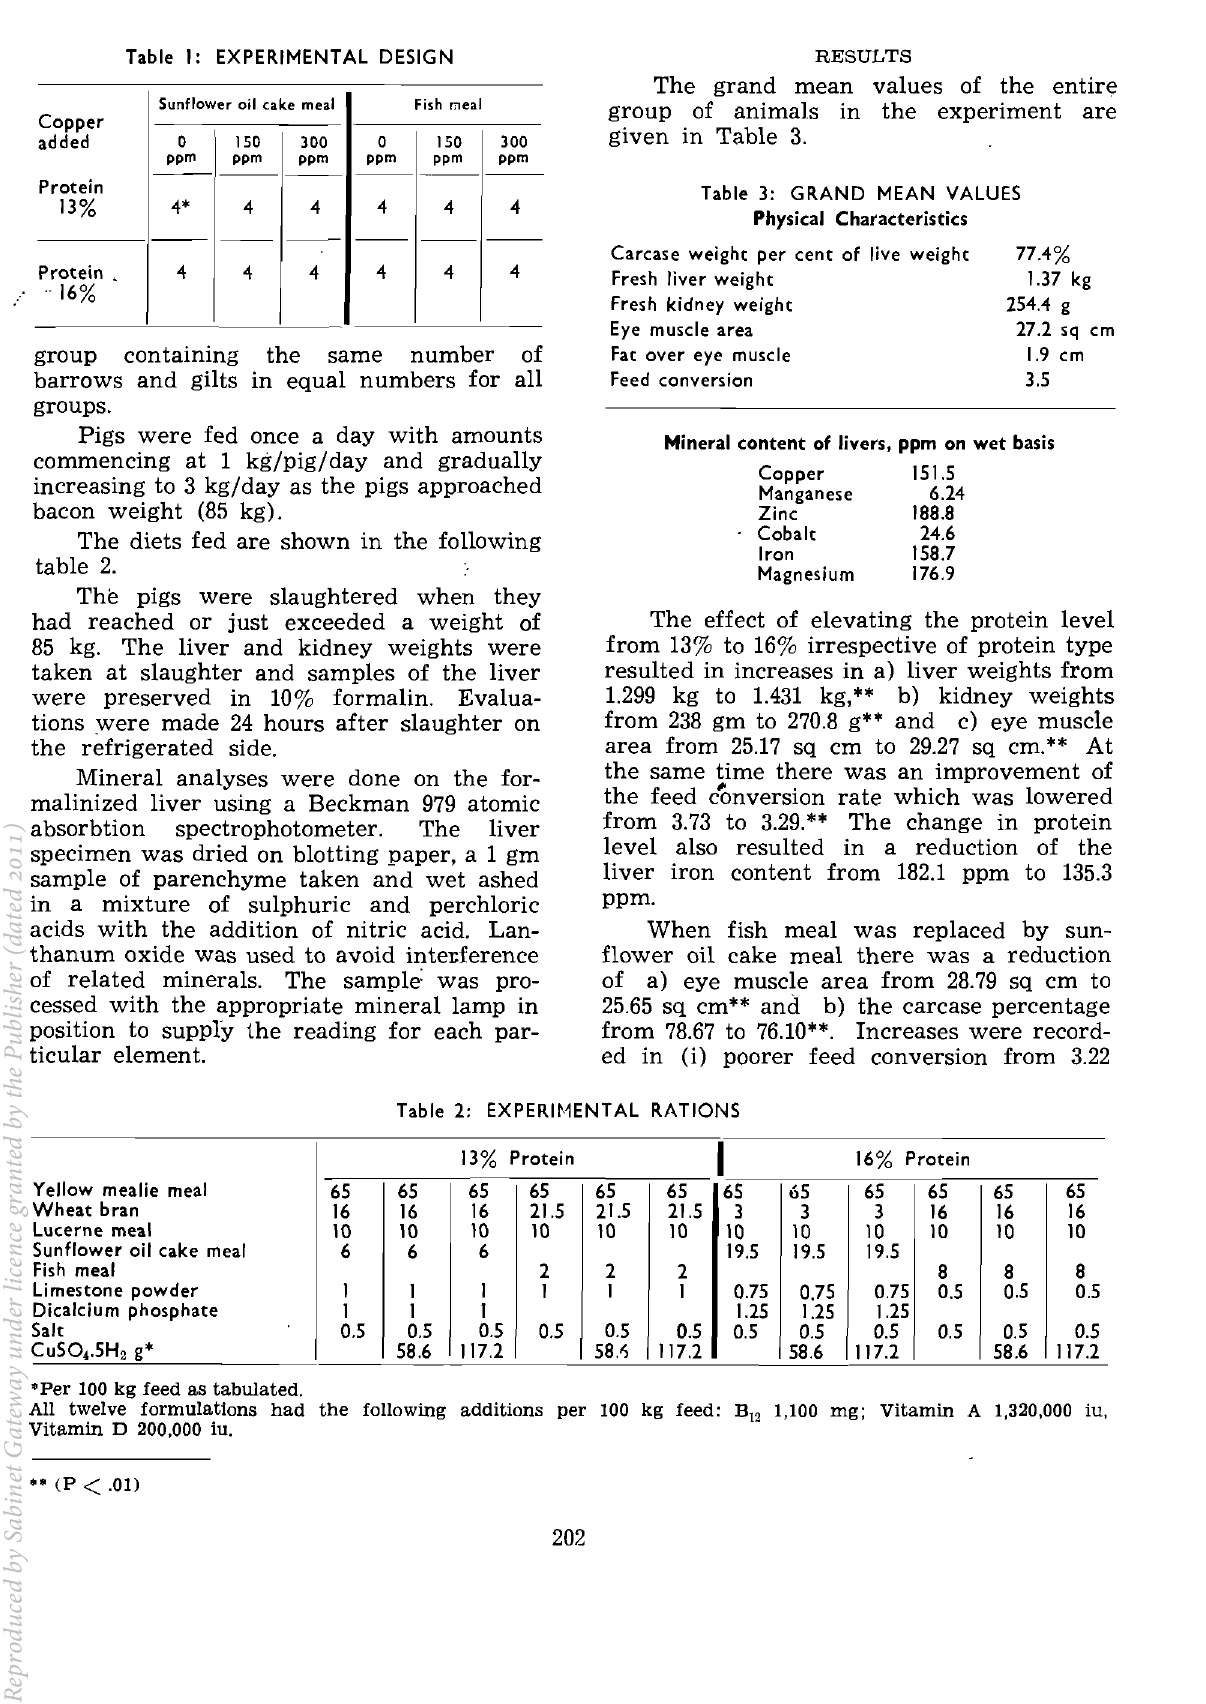
Table I: EXPERIMENTAL DESIGN